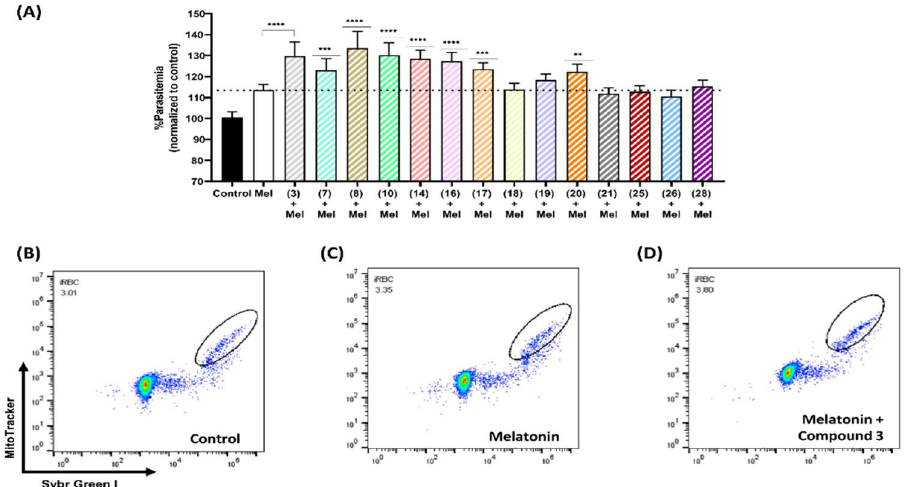
Figure 4. Effects of 2-sulfenyl indoles on the parasitemia of P. falciparum after 48 h of incubation with 500 nM compounds 3 , 7 , 8 , 10 , 14 , 16 , 17 , 18 , 19 , 20 , 21 , 25 , 26 , and 28 in combination with 100 nM melatonin (Mel) ( A ). Dot plots showing SG-I/MT-Red-labeled parasites detected by flow cytometry after 48 h of treatment with DMSO ( B ), 100 nM melatonin ( C ), and a combination of 100 nM melatonin and 500 nM compound 3 ( D ). Data are presented as the percentage of parasitemia normalized to that of the control group treated with solvent (DMSO). Experiments were performed 3 independent times in triplicate. The error bars represent the SD. * indicates a significant difference compared to the melatonin treatment (Mel). Statistical significance was calculated using one-way ANOVA followed by Dunnett’s test: ** p ≤ 0.01, *** p ≤ 0.001, **** p ≤ 0.0001.